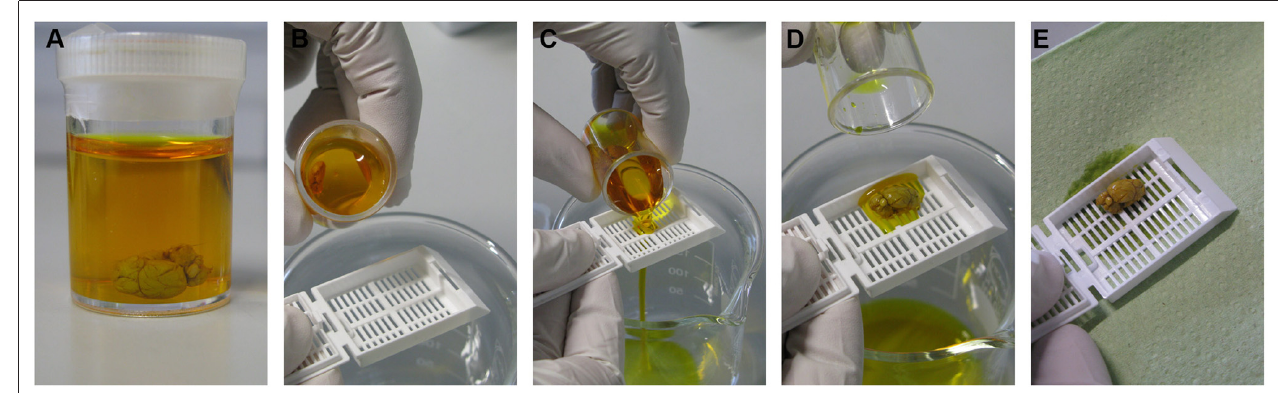
FIGURE 1 | Impregnation step . The brain sample is kept in Golgi-Cox solution at room temperature in the dark (A) . After 24 h, the sample is transferred into a new Golgi solution-containing bottle with the help of a histological cassette as shown in the serial pictures (B–E) and kept to settle at room temperature in dark for 7–10 days.